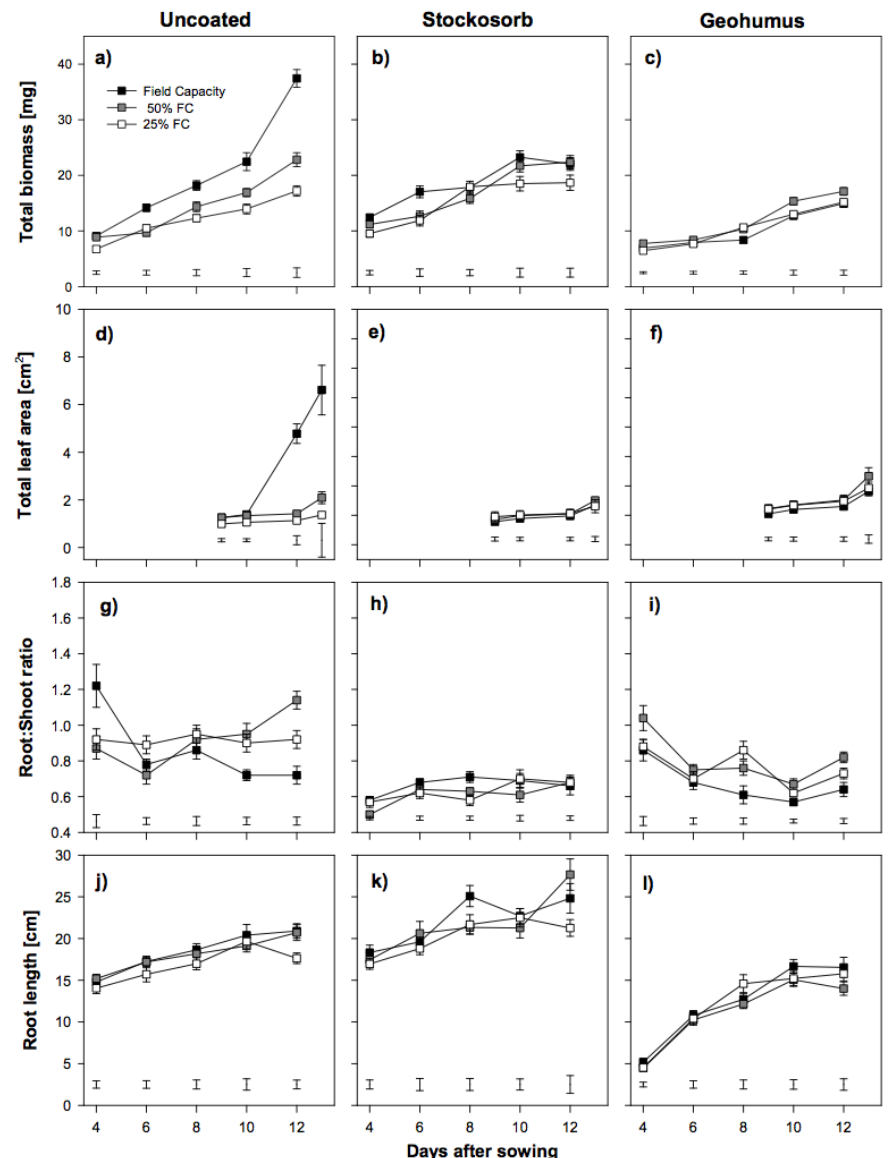
Figure 2. Effects of drought stress on total biomass, leaf area, root:shoot ratio and root length of Piper uncoated ( a , d , g , j ) coated with two hydro-absorbers, Stockosorb ( b , e , h , k ) and Geohumus ( c , f , i , l ). (Bars on data points denote standard error while those in graphs indicate the least significant difference at α = 5% and FC = field capacity).